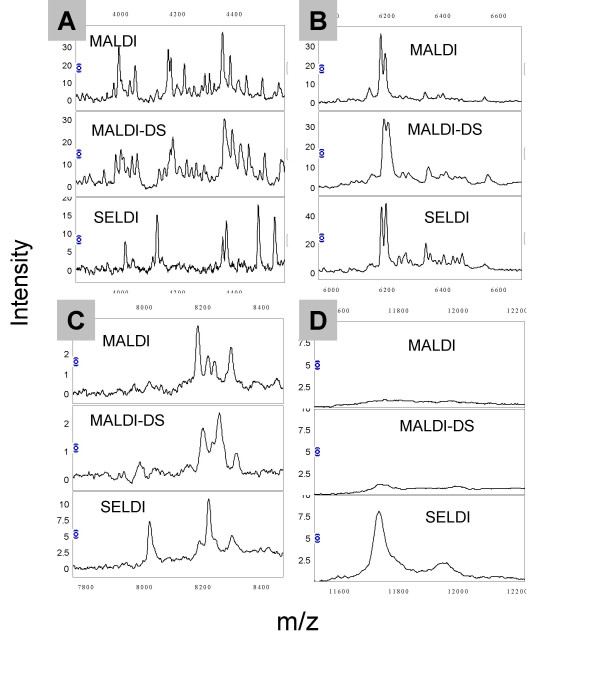
Comparison of MALDI and SELDI urine profiles. Figures 2 a-d show expanded regions of the MALDI, MALDI-DS and SELDI spectra from one female non-cancer subject.